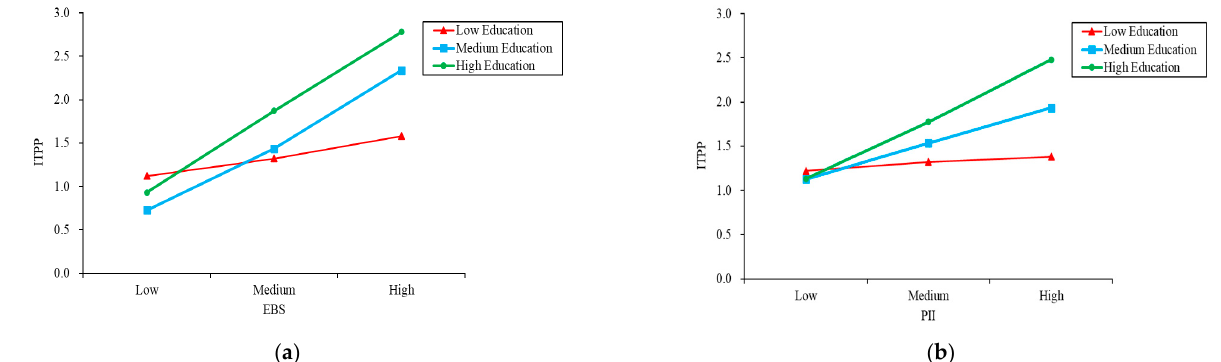
Figure 8. Graphical representation of moderating effects. Note: ( a ) the moderating effect of education on the association of EBS with ITPP; ( b ) the moderating effect of education on the association of PII with ITPP.